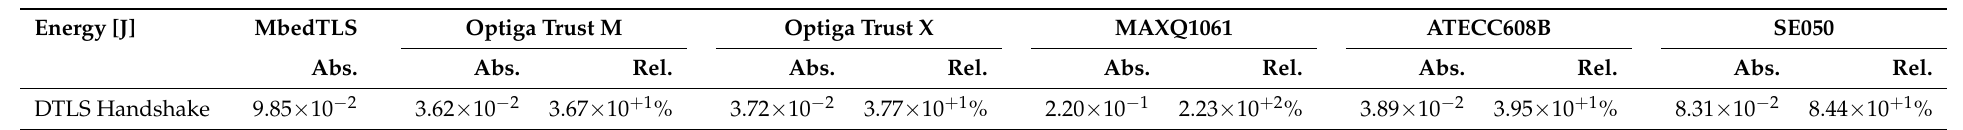
Table A9. Absolute energy consumption (abs.) of the node (MCU) during the DTLS handshake using MbedTLS (reference) and absolute energy consumption of the node (MCU and secure element) during the handshake using the secure elements with percentages relative (rel.) to the reference (median of values, rounded to 3 significant digits, n = (see table